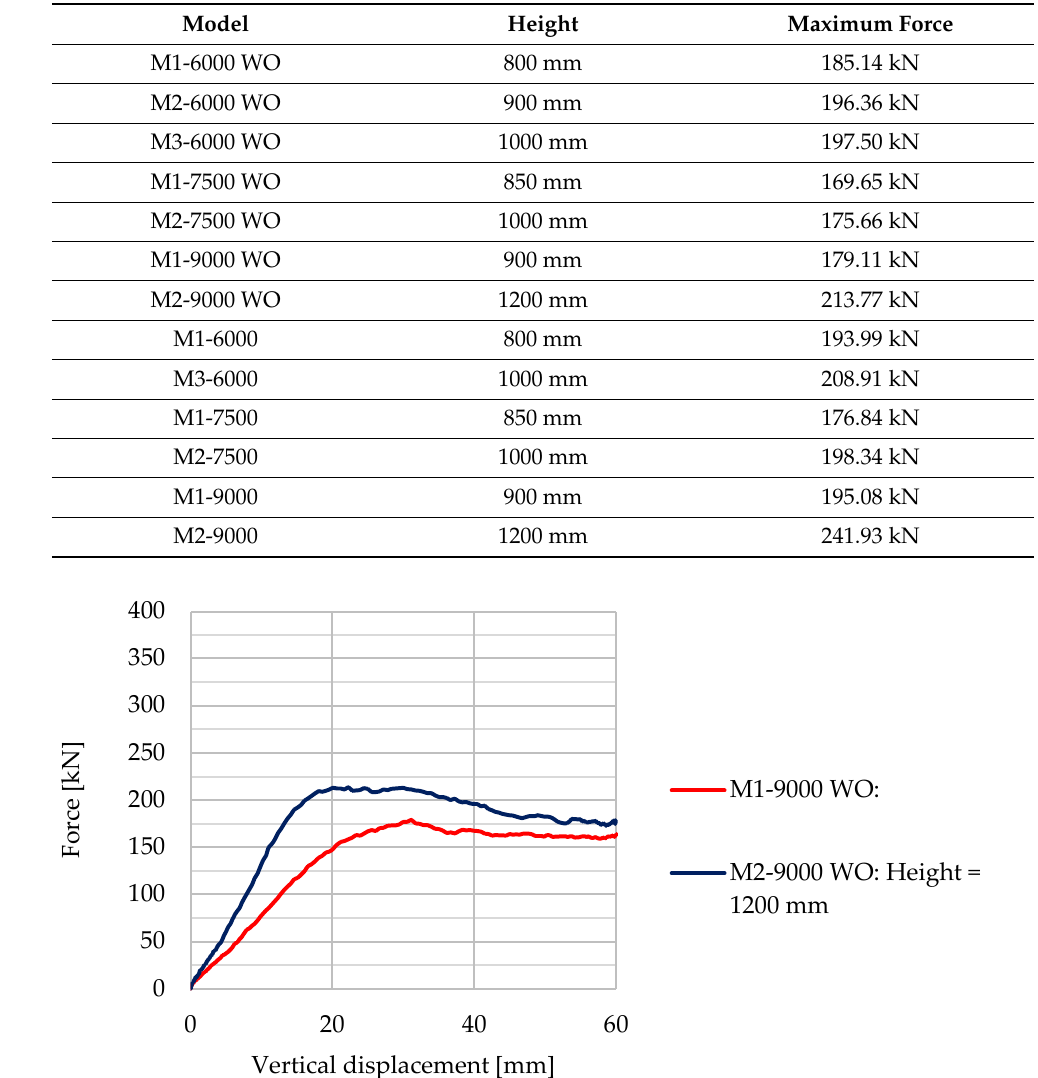
Figure 23. Force–displacement curves for the beam with a web opening, a length of 9000 mm, and different heights.